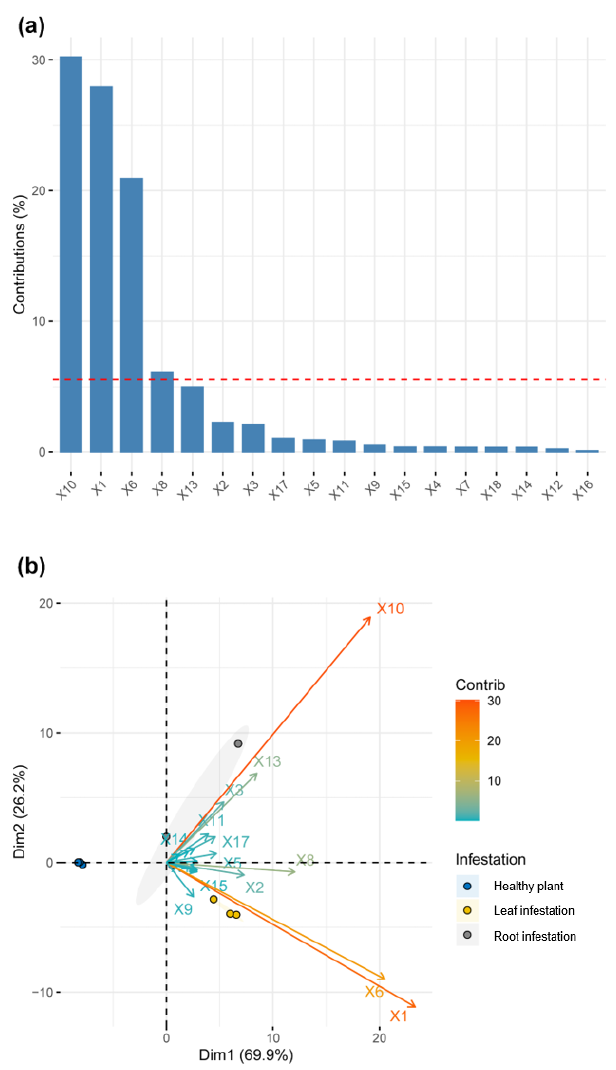
Figure 2. Principal component analysis (PCA) of volatile compounds induced by feeding of Agrotis segetum larvae on cotton plants. ( a ) Contribution of each volatile compound to the first two principal components (PC1 + PC2), which together explained >99% of all variation. The horizontal red dashed line represents the mean contribution (5.3%) of all 18 volatiles. ( b ) PCA biplot for assessing each volatile compound for three different treatments. The points with different colors represent samples from un-infested plants (blue), plants with larval feeding on leaves (yellow), and on roots (gray), respectively. Black lines with arrows indicate volatile compounds that were the top seven contributors to the first two PC-axes. X1: p-xylene; X2: nonanal; X3: tetradecane; X4: hexyl butyrate; X5: 1-hexanol, 2-ethyl-; X6: decanal; X7: pentadecane; X8: benzaldehyde; X9: linalool;